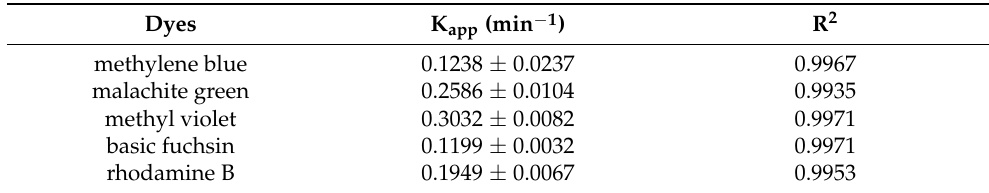
Table 7. The kinetic adsorption parameters obtained using pseudo-first-order for the photocatalytic degradation of various dyes under 405 nm purple